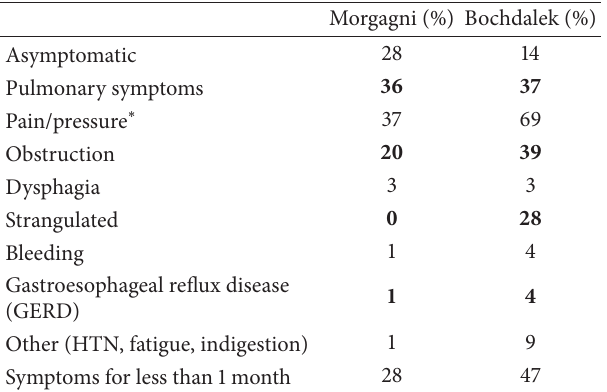
Table 1: Clinical presentation of congenital diaphragmatic hernia in adults.